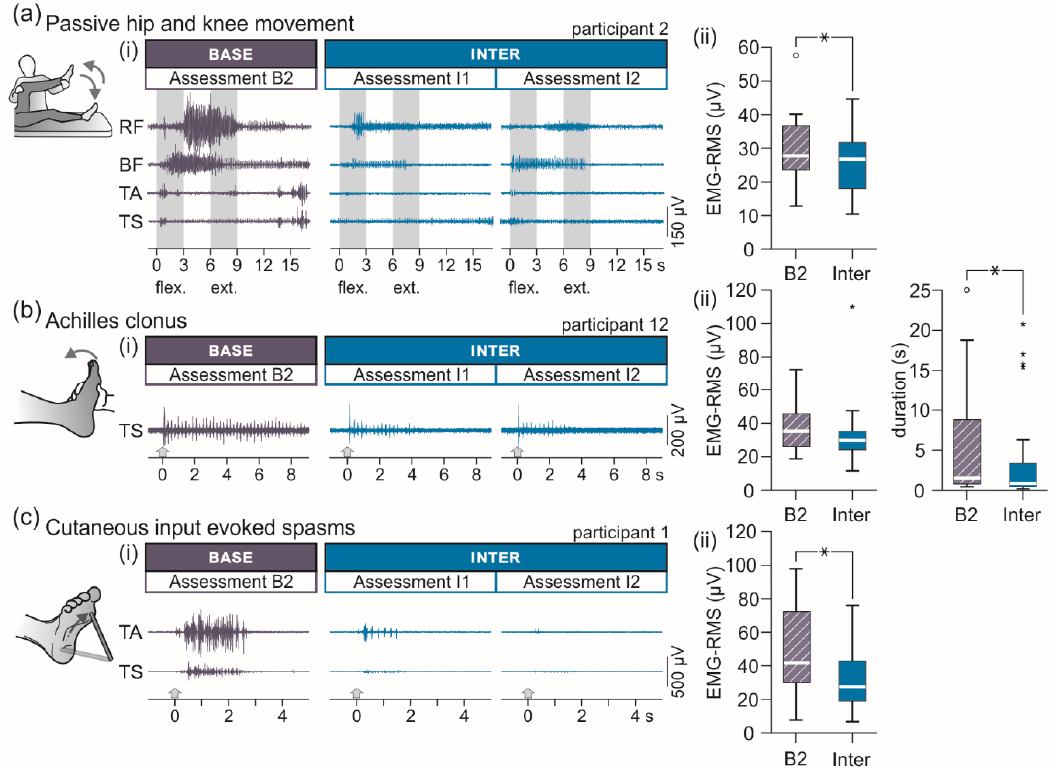
Figure 5. Intermediate carry-over effects of transcutaneous spinal cord stimulation on various presentations of lower- extremity spasticity assessed with surface-electromyography. ( a ) Lower-extremity muscle activation through tonic stretch reflexes during passive unilateral hip and knee flexion (flex.) and extension (ext.) movements. (i) Electromyographic (EMG) recordings derived from rectus femoris (RF), biceps femoris (BF), tibialis anterior (TA), and triceps surae (TS) in assessments B2 as well as I1 and I2; participant 2. (ii) Group results of the root mean square (RMS) values of the EMG in B2 and Inter. ( b ) Achilles clonus elicited by a brisk manual dorsiflexion. (i) EMG recordings of TS in B2 as well as I1 and I2; participant 12. Arrows mark onsets of the tests. (ii) Group results of the EMG-RMS values (left) and clonus duration (right) in B2 and Inter. ( c ) Cutaneous-input evoked lower-extremity spasms. (i) EMG recordings of TA and TS in B2 as well as I1 and I2; participant 1. Arrows mark onsets of the tests. (ii) Group results of the EMG-RMS values in B2 and Inter. B2, baseline assessment conducted immediately pre-intervention; Base, baseline evaluation; Inter, evaluation of intermediate carry-over effects comprising two assessments immediately (I1) and two hours (I2) post-intervention. All group results are illustrated by box plots. Bold horizontal lines within boxes are medians; boxes span the interquartile range. Whiskers extend to the lowest and largest values that are not outliers (illustrated as circles; see Methods) or extreme values (asterisks). Brackets and asterisks denote significant results of post-hoc pairwise comparisons (*, p <